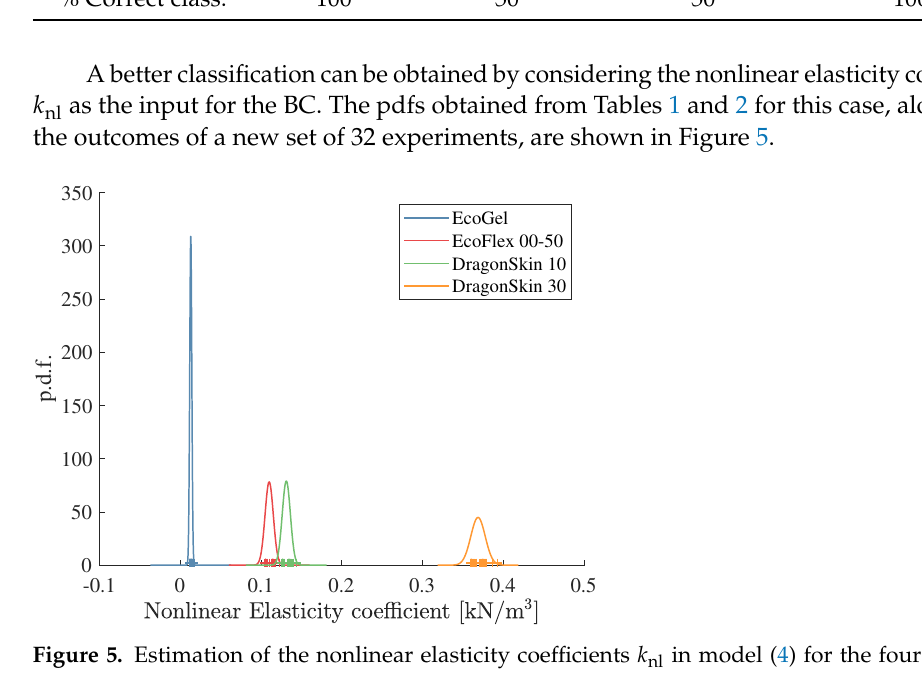
Table 3. Percentage of correct classifications when considering ˆ k l as the BC input. Material